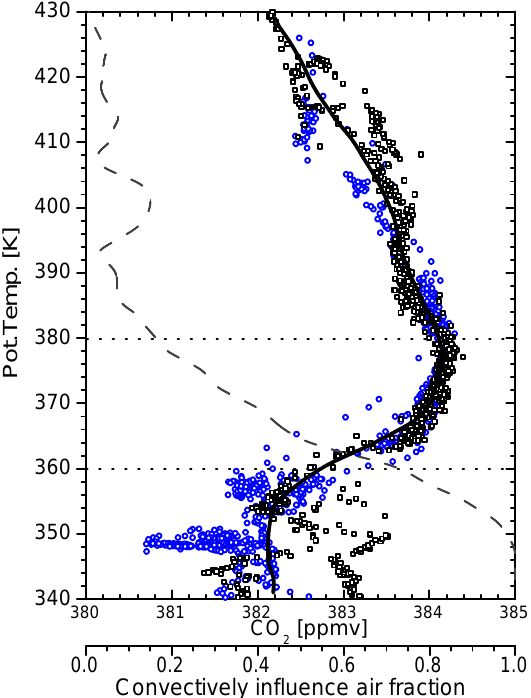
Fig. 1. Vertical profiles of CO 2 from two science flights in the trop- ics ( < 11 ◦ N) on 5 (denoted by blue empty circles) and 6 August(by black empty squares) during TC4. The line is a fit (locally-weighted least squares, “lowess”) to averages in 1-K intervals of potential temperature. Fraction of air cluster points with non-zero convective influence, which was calculated by back trajectory analyses to con- vective systems, based on the method of Pfister et al. (2001, 2010). The dashed line shows the 1-K averaged fraction of air clusters in- fluenced by convection for 14 day trajectories, which is concen- trated mainly below the TTL, reducing to low values above 360 K. For the higher levels (near 400 K), the occasional impact of convec- tion seems to appear in the convective influence fraction and short lived species, but not in the CO 2 profile. Two horizontal dotted lines denote the bottom of the TTL and cold point temperature